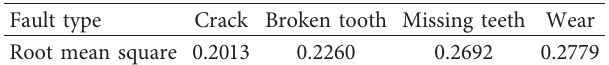
Table 2: Root mean square values of DCSMDE values for different fault types.